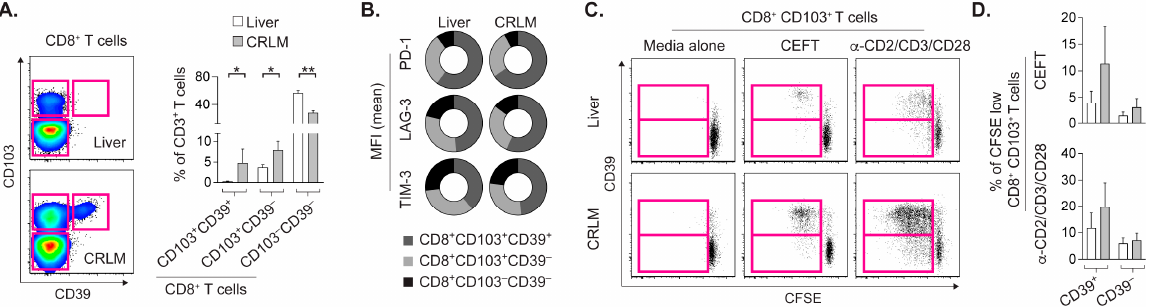
Figure 2. Proliferating CD8+ T RM cells during cognate stimulation express CD39. ( A ) Gating of CD8+ T RM cells expressing CD103 (tissue residency marker) with or without co-expression of CD39 (indicator of extended activation), and ex vivo frequency of T RM cell subsets, plus CD103 − CD39 − CD8+ T cells among CD3+ T cells in liver and CRLM. ( B ) Proportions of the mean MFI of PD-1, LAG-3 and TIM-3 staining on indicated T cell subsets. ( C ) CFSE-labeled CD8+CD103+T RM cells diluting CFSE dye for 4 days as they proliferate during cognate response to peptide mixture based on microbial antigens (CEFT). Polyclonal stimulation with anti-CD2/CD3/CD28 antibodies on microbeads served as positive control. ( D ) Background-subtracted frequency of the CD8+CD103+ T RM cells expressing CD39 or not among proliferating (CFSE-low) T RM cells. Means with SDs shown (* p <0.05, ** p <0.01, Wilcoxon test).